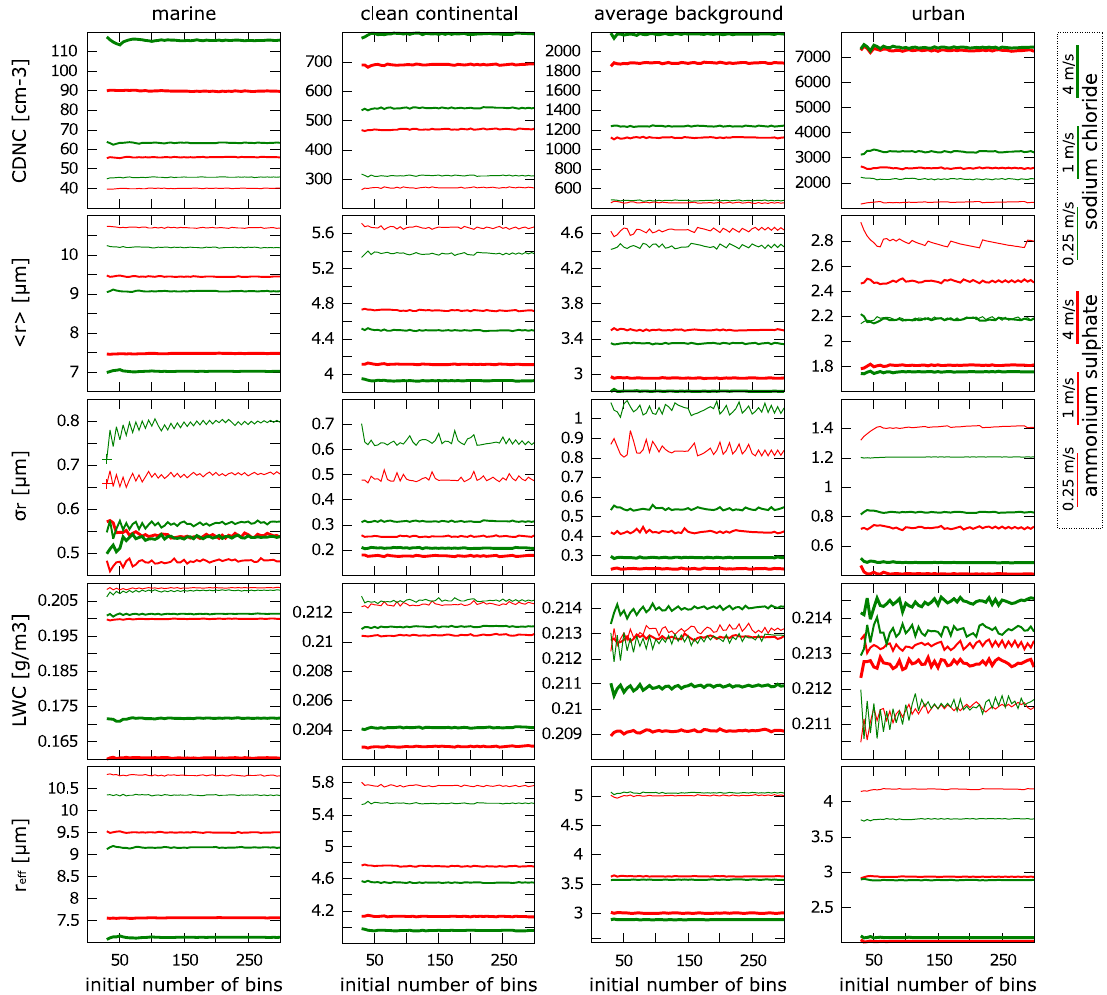
Fig. 5. A summary of results obtained with adaptivity in the 1296 model runs discussed in Sect. 3.3 (see text for details). Figure 4 presents analogous results obtained without adaptivity (see caption for explanation of the plot